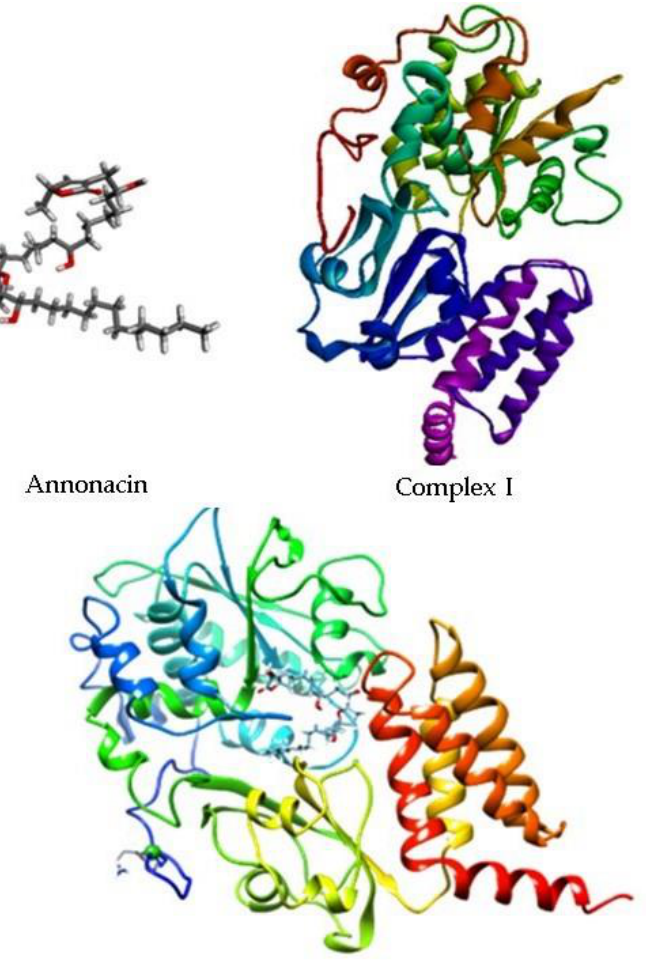
Figure 8. 2D representation of molecular anchorage obtained by SwissDock. Source: Authors.